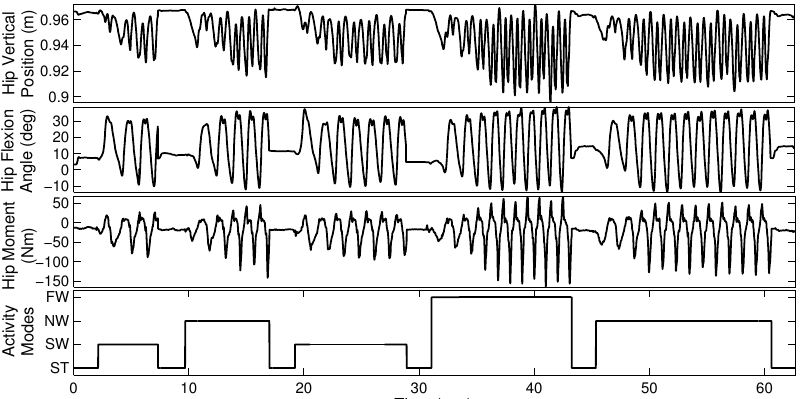
Figure 3. Sample walking trial with four different gait modes for able-bodied subject AB01. Although data is available for both legs, we require only one side for gait mode recognition. The data from the two legs look similar because of gait